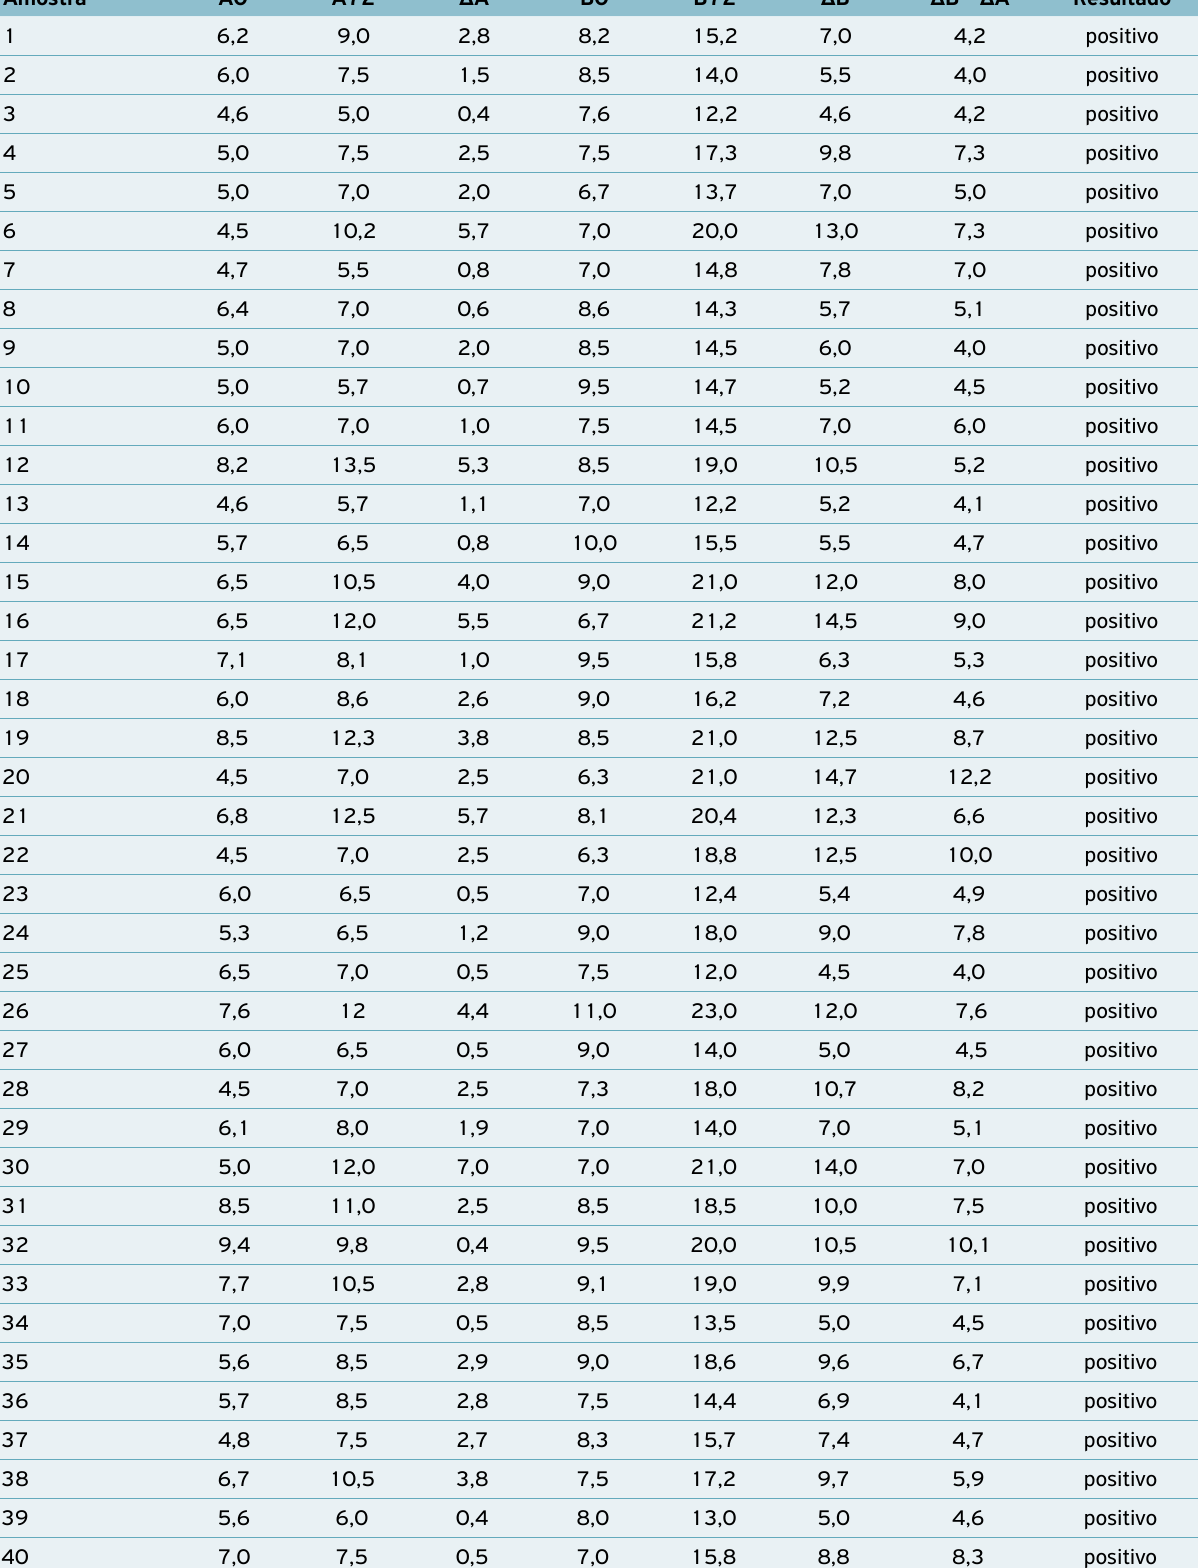
Tabela 1. Resultado do exame de tuberculinização de 40 bovinos reagentes no teste cervical comparativo. Os resultados são expressos em mm e interpretados de acordo com a tabela do regulamento técnico do Programa Nacional de Controle de Erradicação da Brucelose e Tuberculose Animal